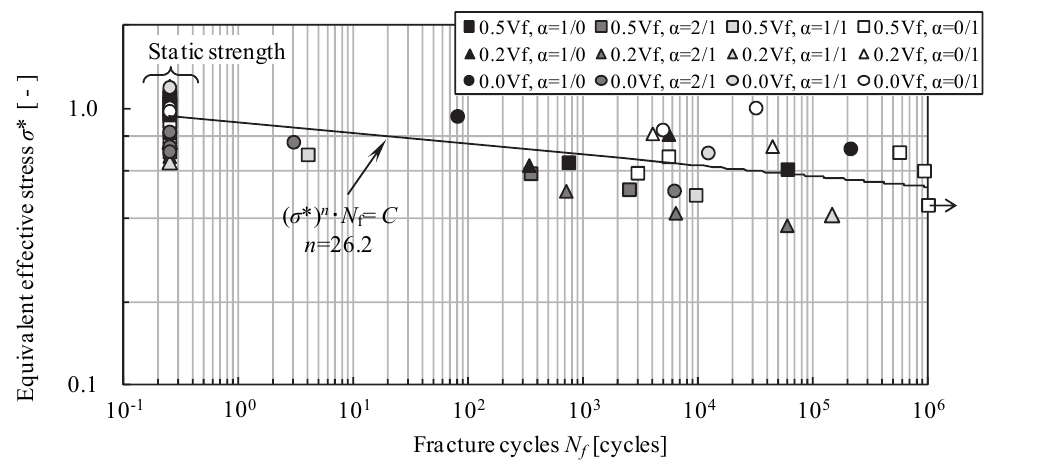
Figure 5: Relationships between σ * and N f with various α in C-SGP.